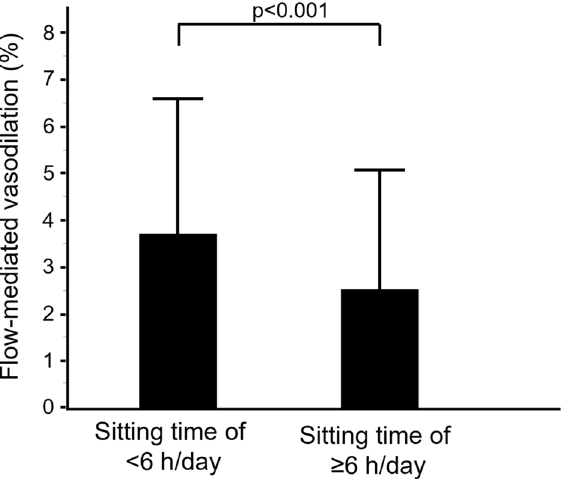
Figure 1. Bar graphs show flow-mediated vasodilation in subjects with sitting time on a non-working day of < 6 h/day and subjects with sitting time on a non-working day of ≥ 6